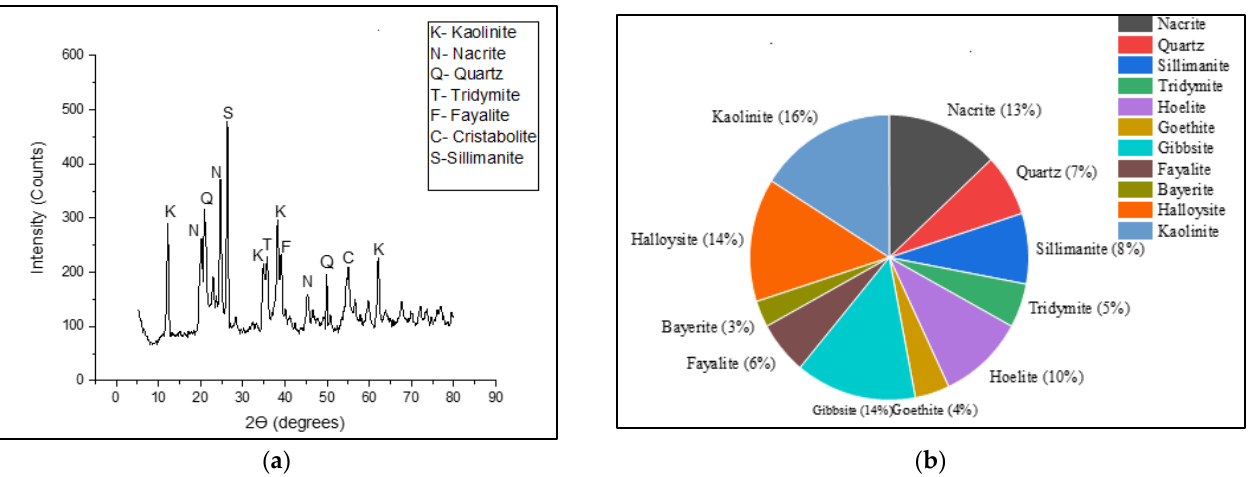
Figure 8. Characterization of minerals and compounds; ( a ) XRD analysis of Manipal sample; ( b ) quanti fi cation of compounds.